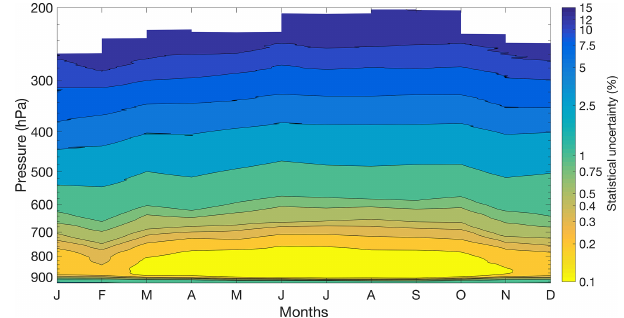
Figure 3. The average statistical uncertainties (represented as per- centage of uncertainty) for each month as a function of pressure. The highest statistical uncertainty is 14% of the water vapour mix- ing ratio between 275 and 250hPa, or between 11 and